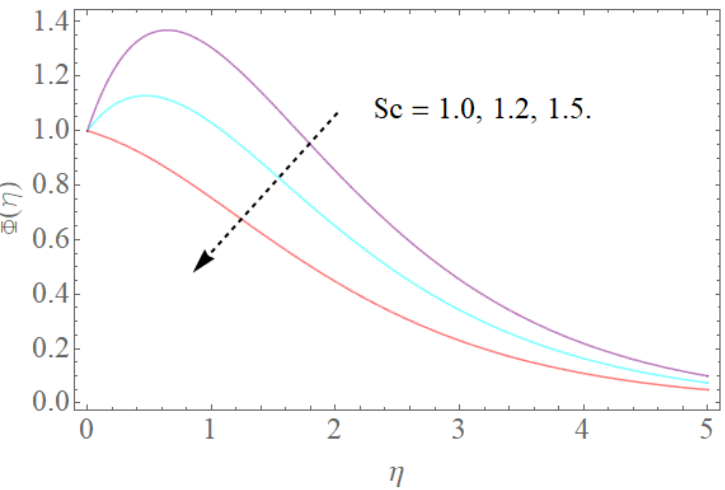
   N N   . when 0.3, 0.2 t b